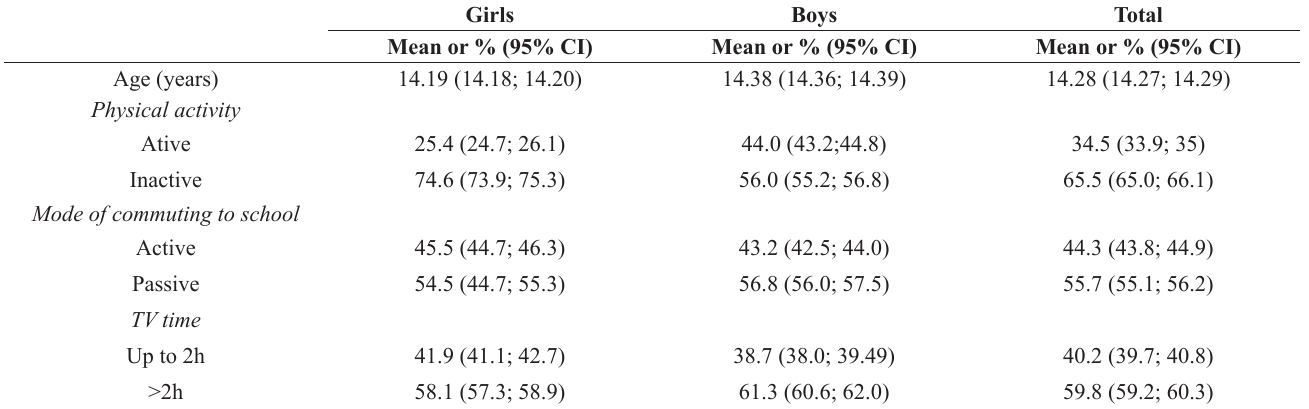
Table 1- Sample characteristics by sex.